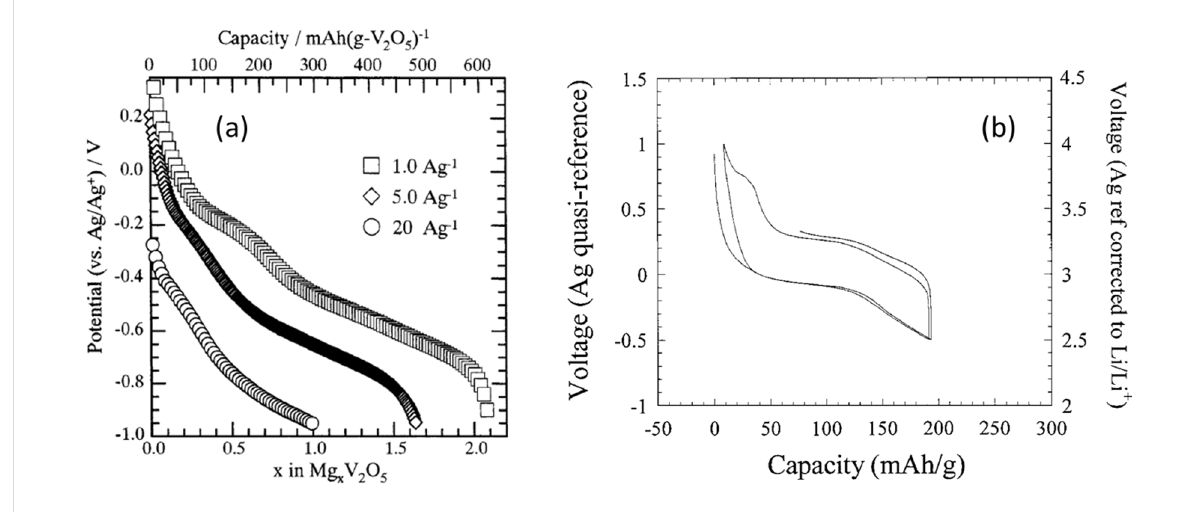
Figure 9: (a) Discharge curves of V 2 O 5 /carbon composites in the Mg(ClO 4 ) 2 /acetonitrile electrolyte solution at various current densities. Reproduced with permission from [70]. Copyright 2003 ECS–The Electrochemical Society. (b) Charge–discharge curves of nanocrystalline V 2 O 5 in the Mg(ClO 4 ) 2 / propylene carbonate electrolyte solution. Reproduced with permission from [72]. Copyright 2001 ECS–The Electrochemical